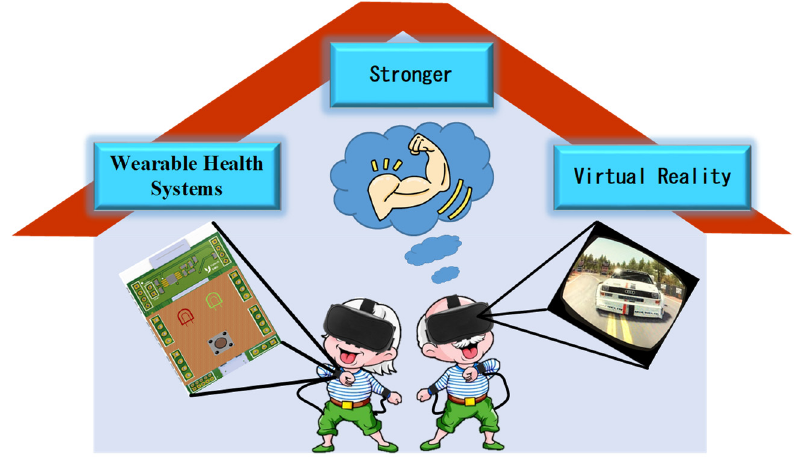
Figure 1. Schematic diagram of a system usage scenario.